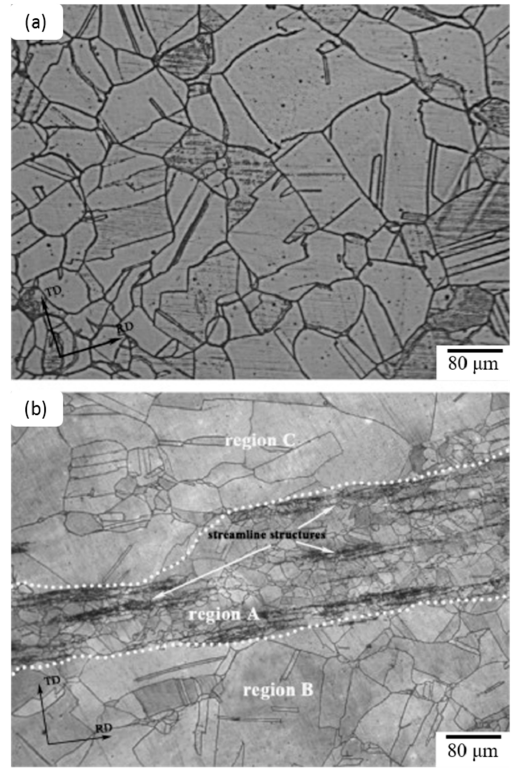
Figure 10. Initial microstructure of test steels in hot-rolled + annealed condition. Steel ( a ) without and ( b ) with RE metals [58]. Materials 2016 , 9 , 417